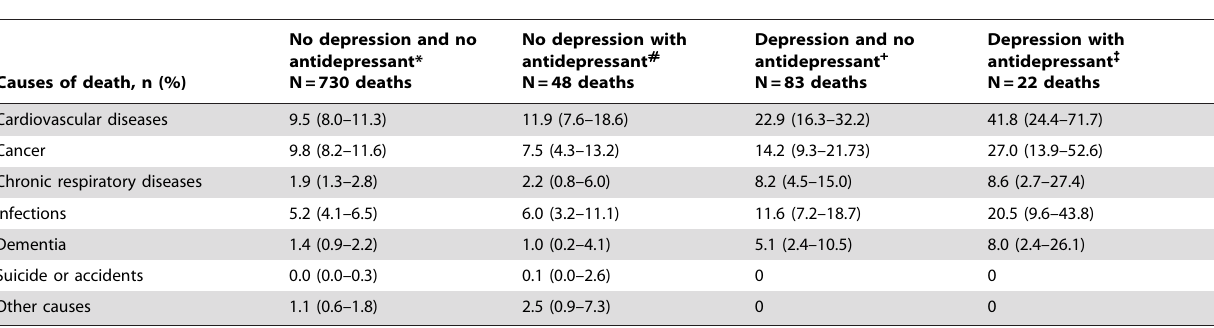
Table 4. Mortality rates (95% confidence interval) per 1,000 persons per year according to depression (GDS-15 $ 7) and antidepressant